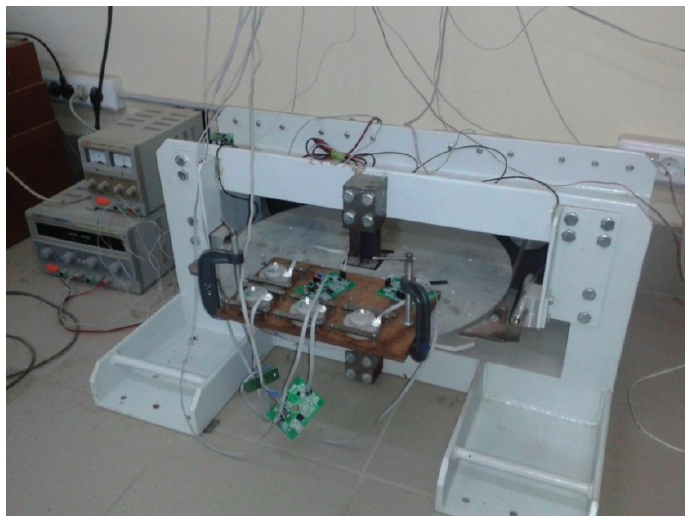
Figure 5. Rotatory calibration vibration